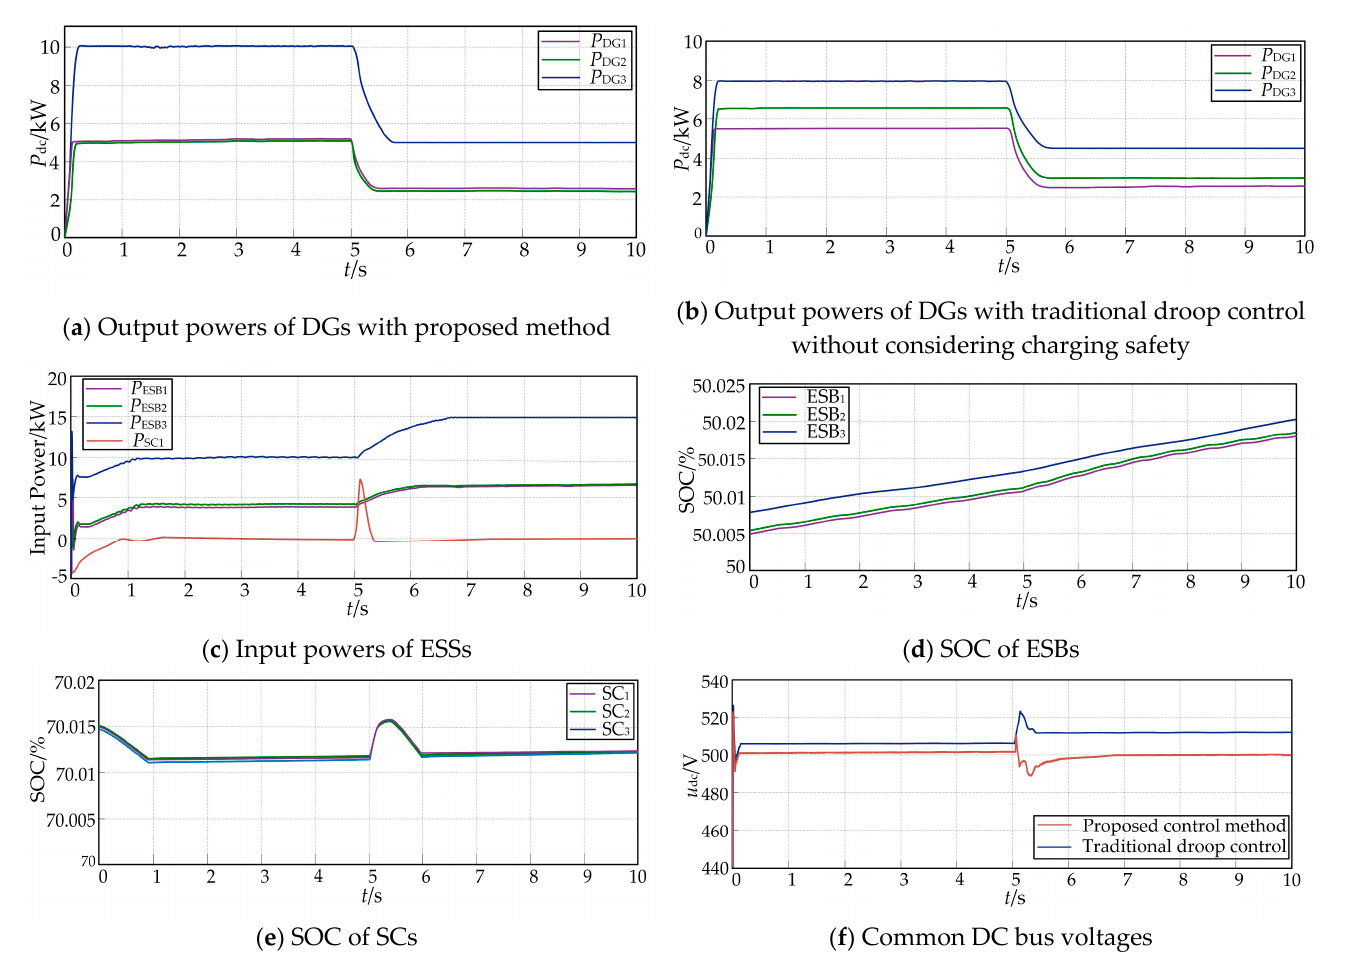
Figure 15. Simulation results in Example 1.